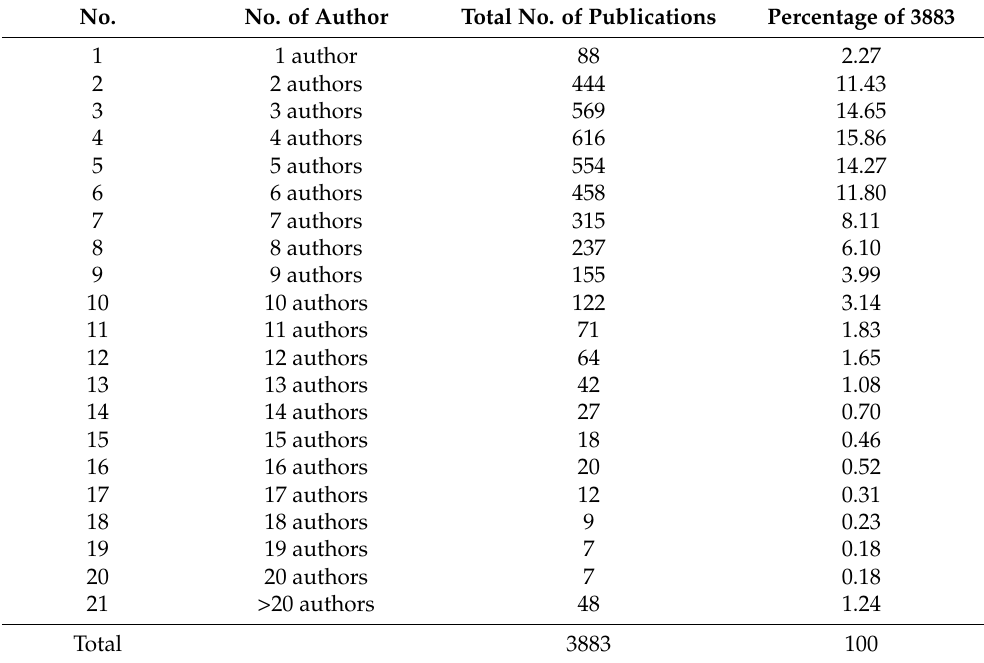
Table 1. Chiang Mai university’s authorship pattern of publications trends in science and technology.